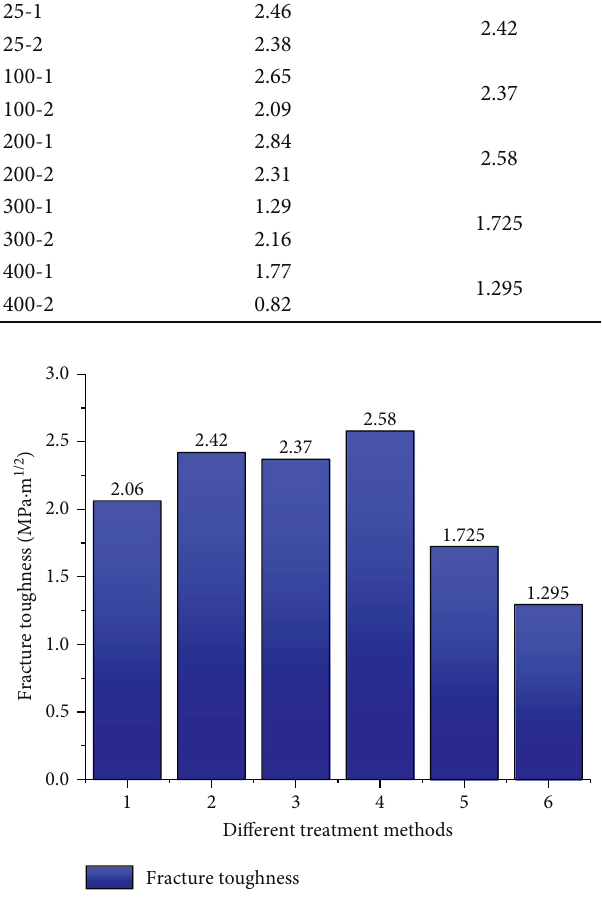
Figure 9: Fracture toughness of rock samples with di ff erent treatment